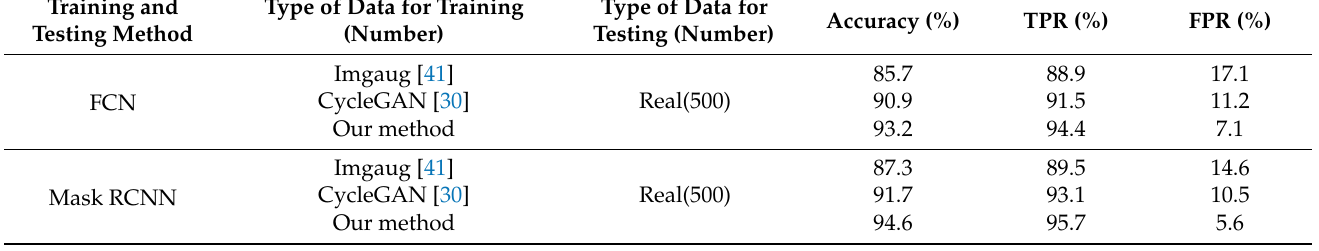
Table 2. Test results of similar data sets.